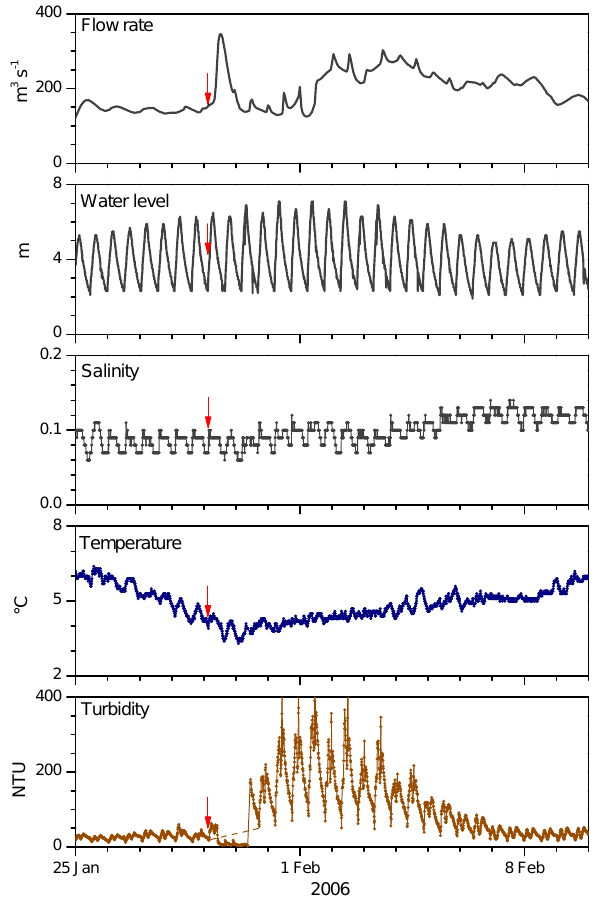
Figure 6. Temporal evolution of flow rate (m 3 s -1 ), water level (m), salinity, temperature (°C)1 and turbidity (NTU) from January, 25, to February, 10, 2006 at the station Libourne on the2 Dordogne river. The arrows point out the time of the dam rupture. The dashed line (lower3 panel) simulates the expected increase in turbidity minimum.4